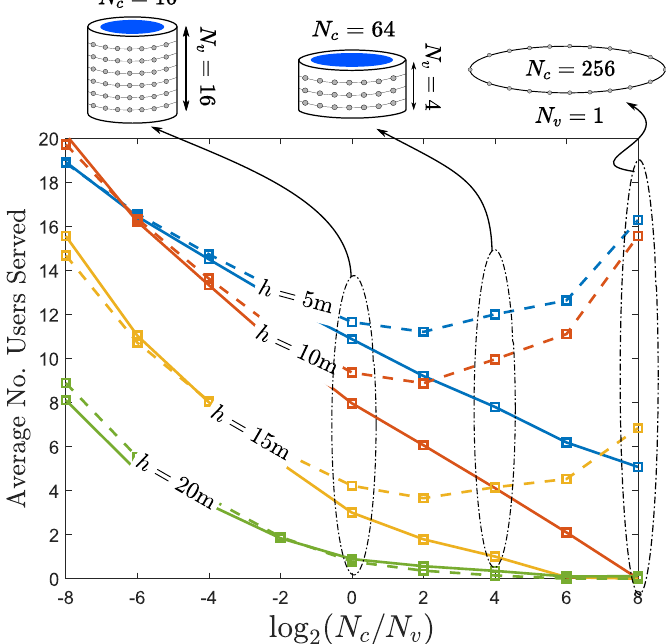
( N c / N v ) , within ¯ R = 100 m 2